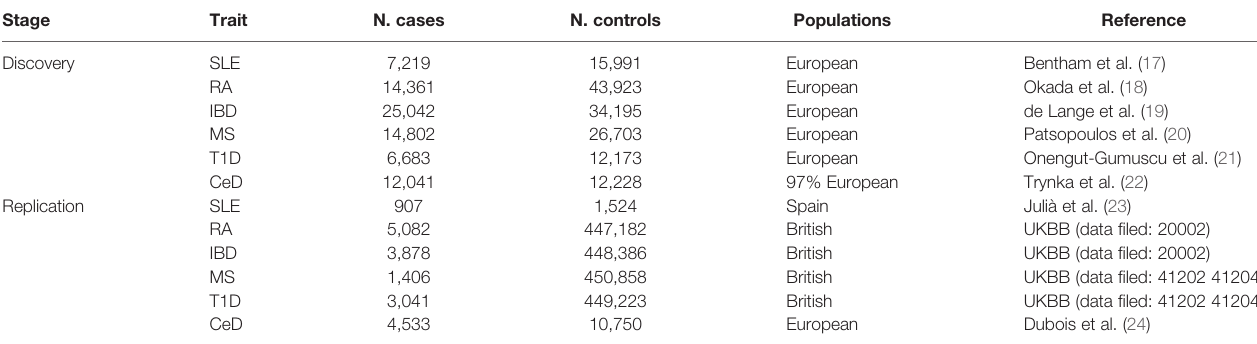
TABLE 1 | Autoimmune diseases GWAS samples used in this